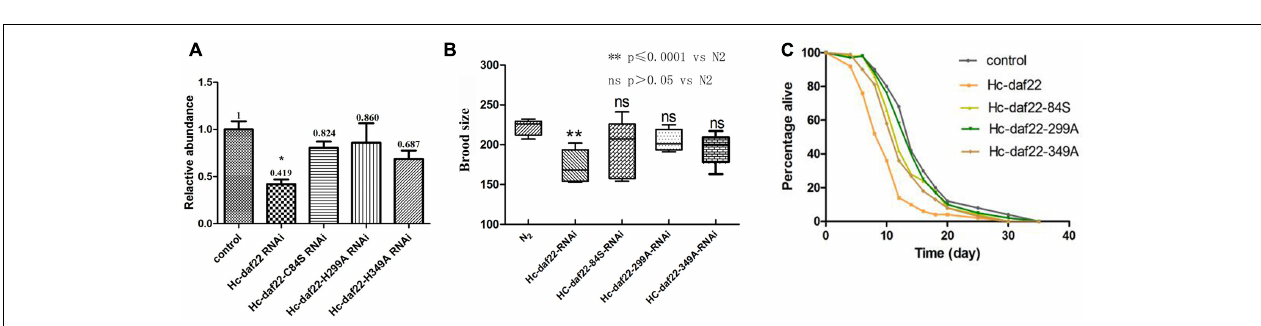
FIGURE 6 | Statistical analysis of brood size and life span of the strains in the RNAi experiment, N2 strain was used as control. RNAi plates were prepared according to standard method and synchronized L1 worms were put on the plates and cultured for certain days. (A) Relative quantification of Ce-daf-22 mRNA in RNAi strains, Ce-actin-1 was used as reference gene. Compared to N2 strain, Hc-daf-22 RANi group showed significant decrease of Ce-daf-22 mRNA while three mutants showing a little decrease but the changes were not significant. (B) Brood size analysis of RNAi strains. Egg numbers of Hc-daf-22 RNAi adults decreased significantly compared to N2 strain, meanwhile mutant groups had no significant changes. (C) life span of RNAi strains. Fifty adults in each RNAi group were picked into clear RNAi plates and survival rate were recorded every day until all worms died.